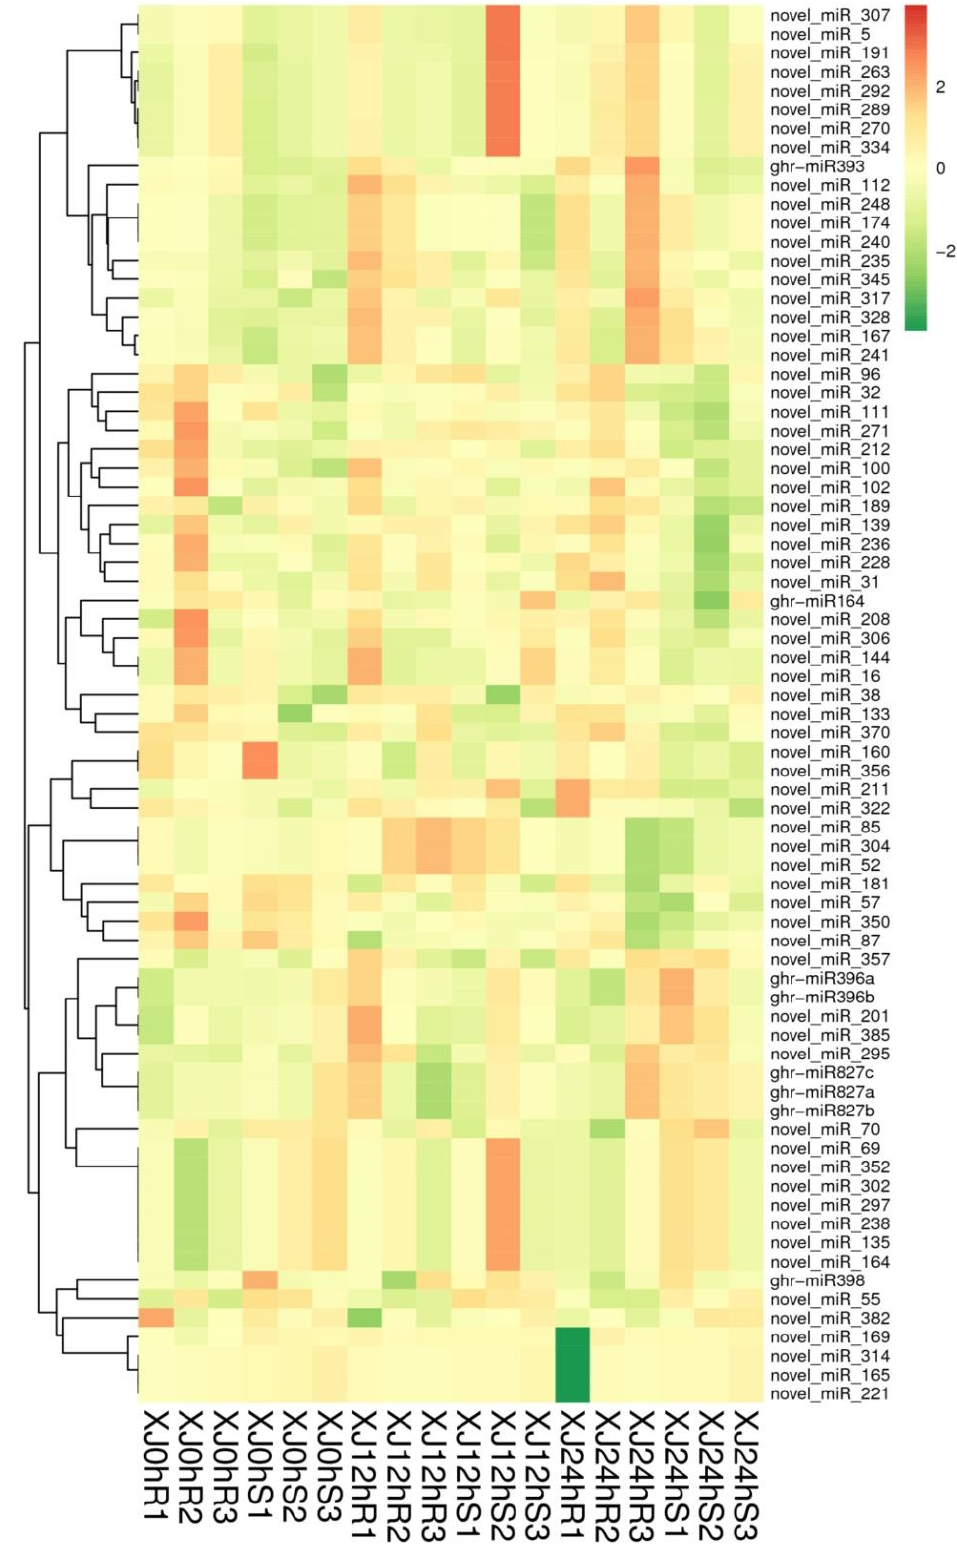
Figure 5. Cluster map of differentially expressed miRNAs. Note: The diagram above depicts a clustering map of differentially expressed miRNAs. The columns indicate various samples, while the rows represent different miRNAs. Log10 (TPM + 1 × 10 − 6 ) values are used for clustering. MiRNAs with high expression are represented by red, while miRNAs with low expression are represented by green.